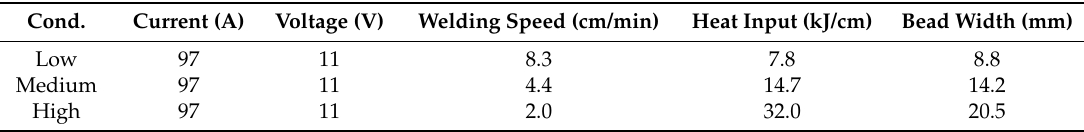
Table 3. Welding conditions of bead-on-pipe single-pass